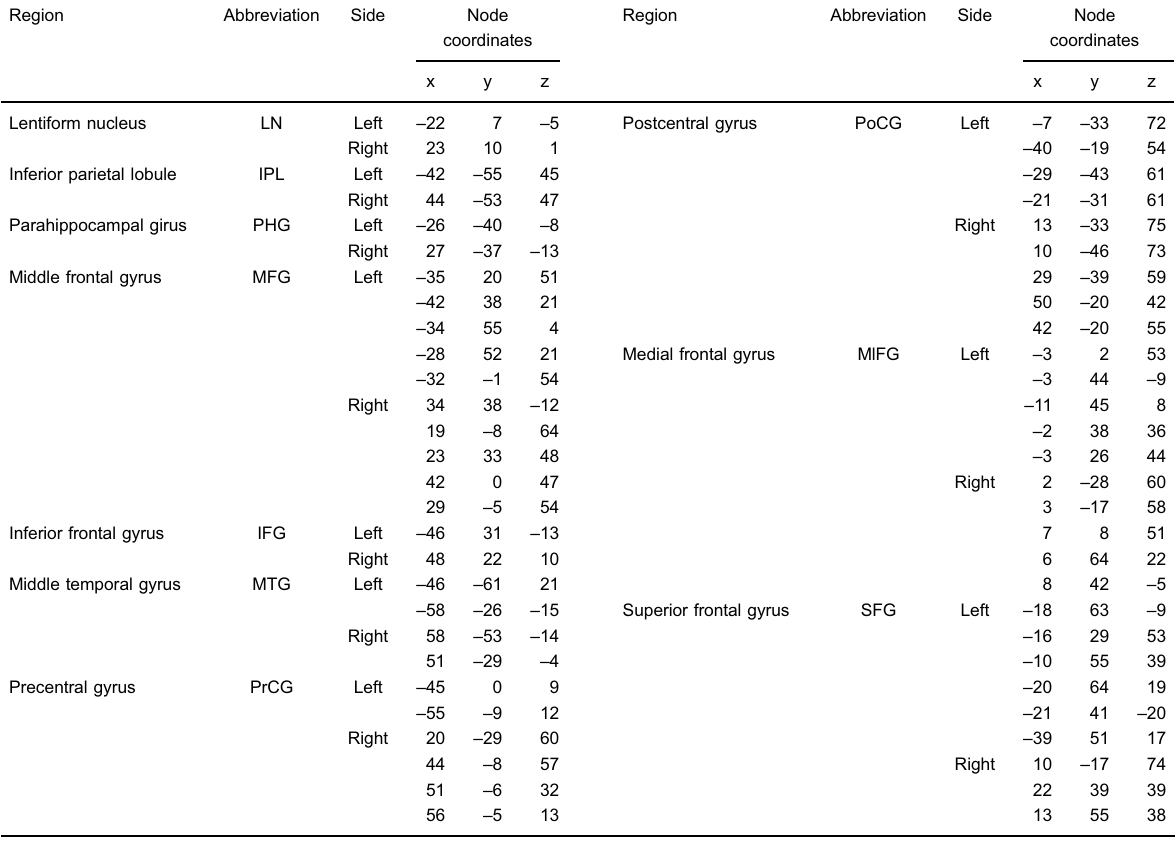
Table 1. Regions of interest analyzed through anatomical regions of the automated anatomical labeling atlas.